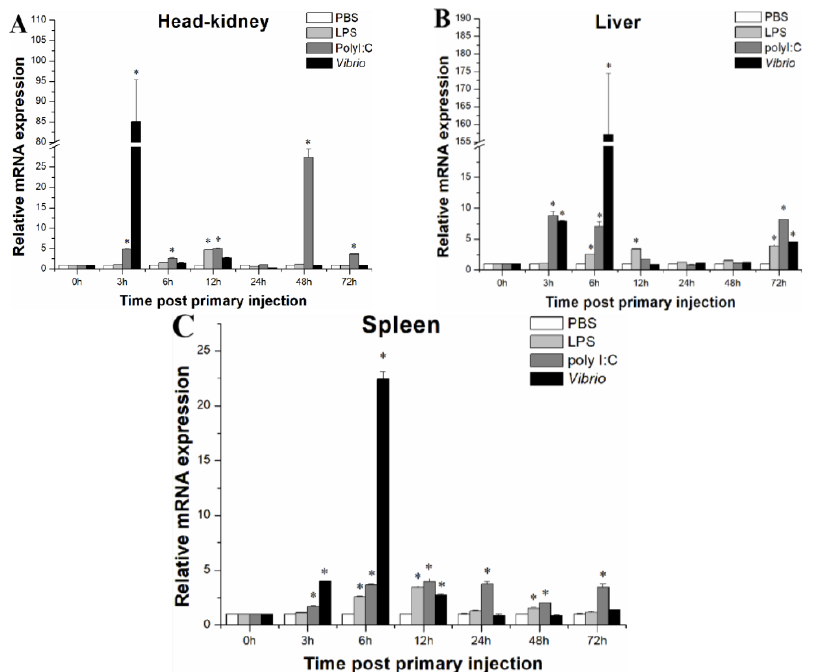
Figure 3. The expression level of LcASC upon various immune stimulation in large yellow croaker head kidney ( A ), liver ( B ), and spleen ( C ). The expression levels of LcASC were examined by qPCR. Data are expressed as the relative expression value (means ± S.D., n = 5) and normalized against β -actin (* p < 0.05). The experiment was conducted in three replications.